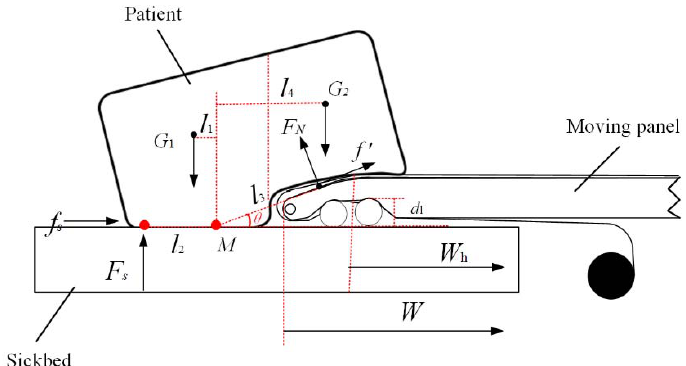
Figure 6. Force analysis model at insertion end of the patient transfer robot.